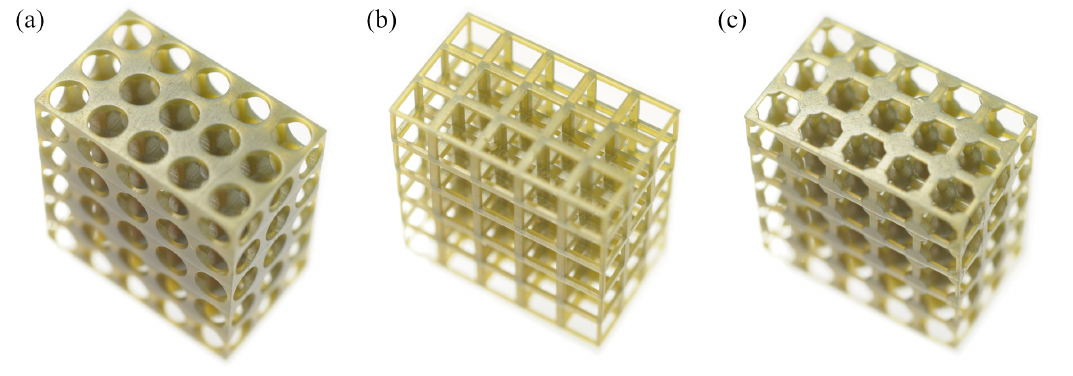
Figure 4. Photographs of fabricated simple cubic phononic crystals with 3 mm lattice constant consisting of ( a ) three cylindrical holes; ( b ) rectangular scaffold; and ( c ) corner balls connected by cylindrical beams, corresponding to the designs in Figure